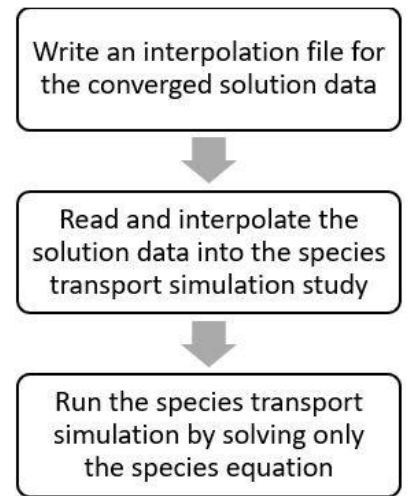
Figure 3. Workflow of the interpolated solution.